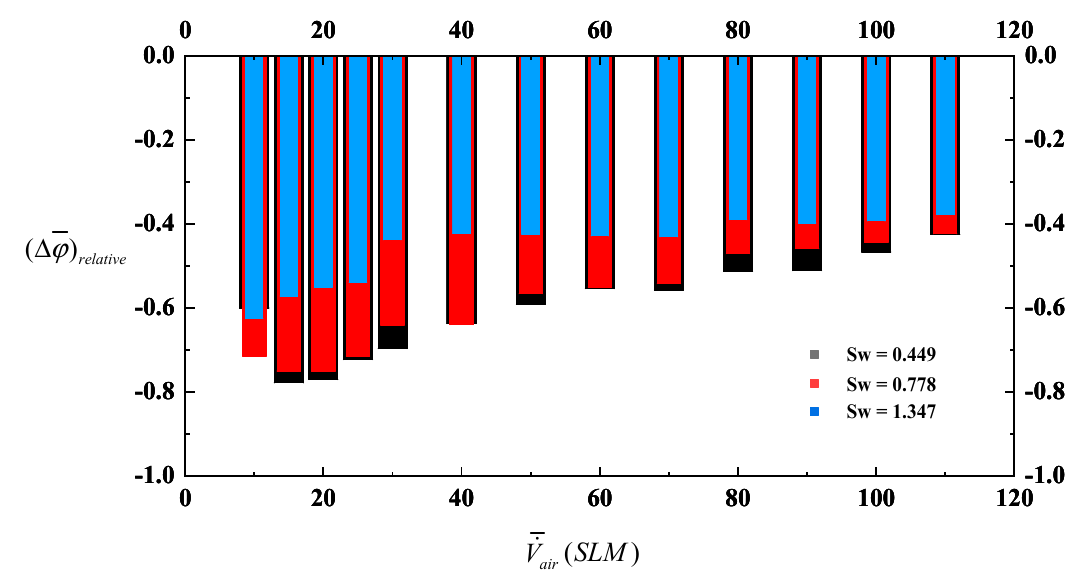
Figure 12. The lean blowout limits in plasma-pulsating flow mode.